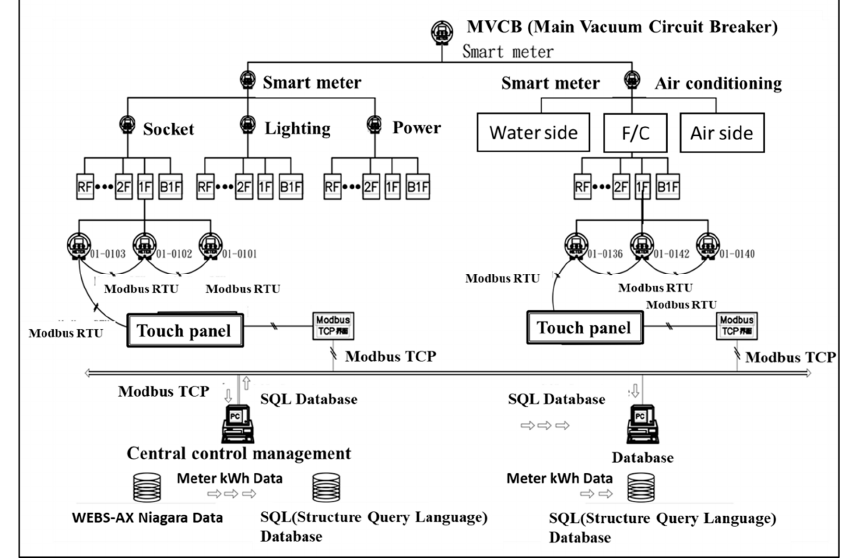
Figure 2. Smart meter system.